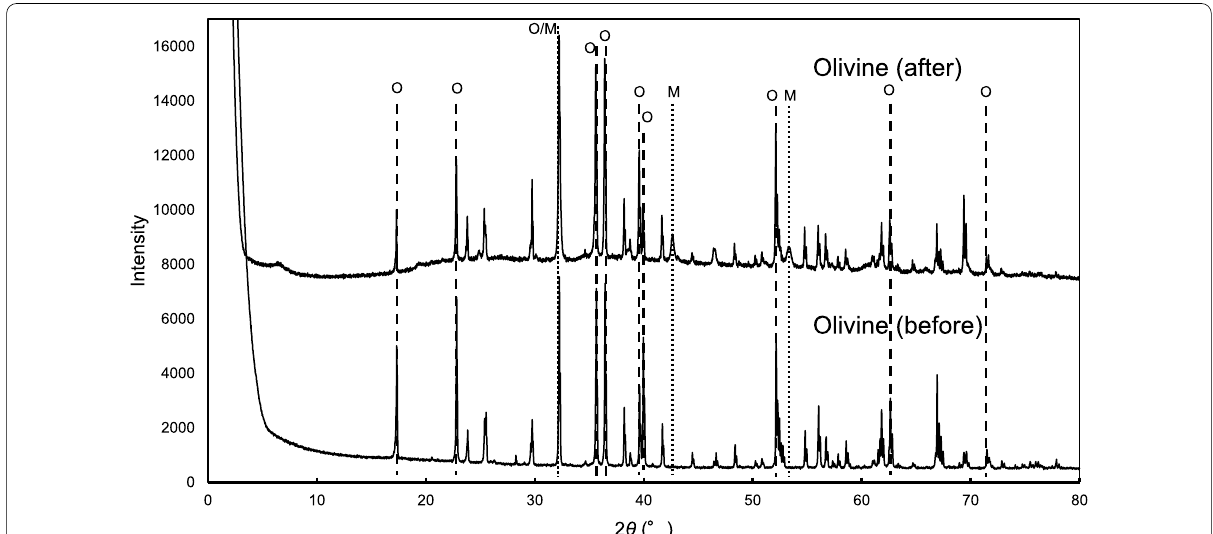
Fig. 1 XRD patterns of olivine before (lower) and after (upper) the experiment. The bulk structure of olivine did not change after heating with organic mixture. New peaks due to magnesite appeared in the XRD pattern of olivine (after). O: Olivine, M: